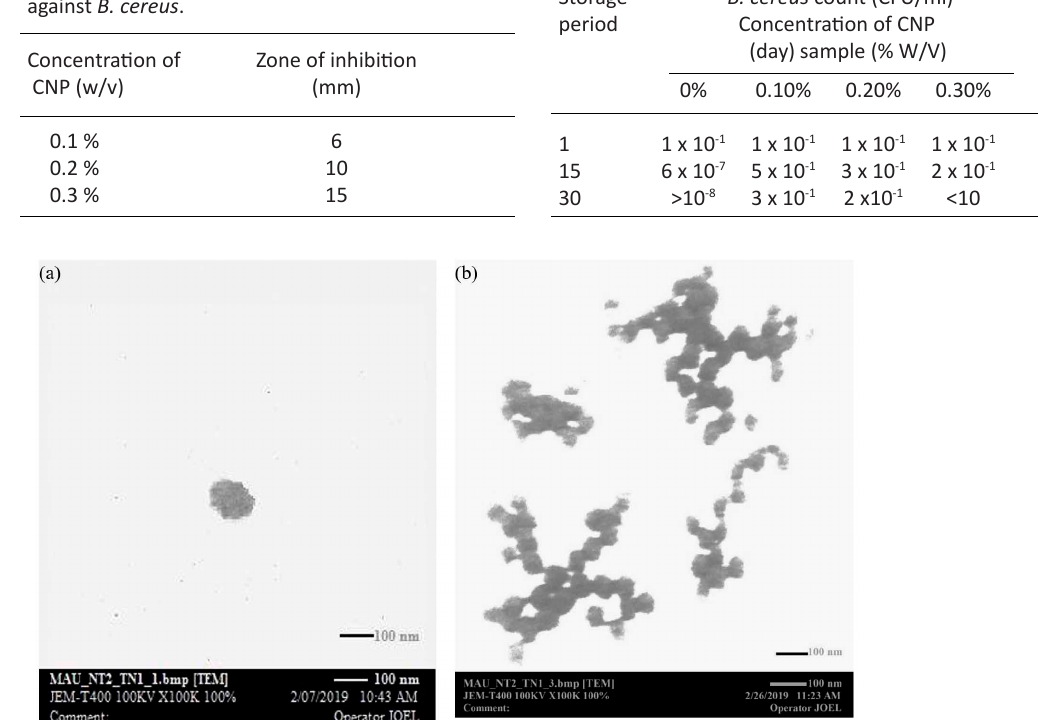
Fig. 2. TEM photographs of chitosan nanoparticles (a) freshly prepared with size diameter range of 90nm -100nm; (b) two weeks of storage with size diameter range of 120nm